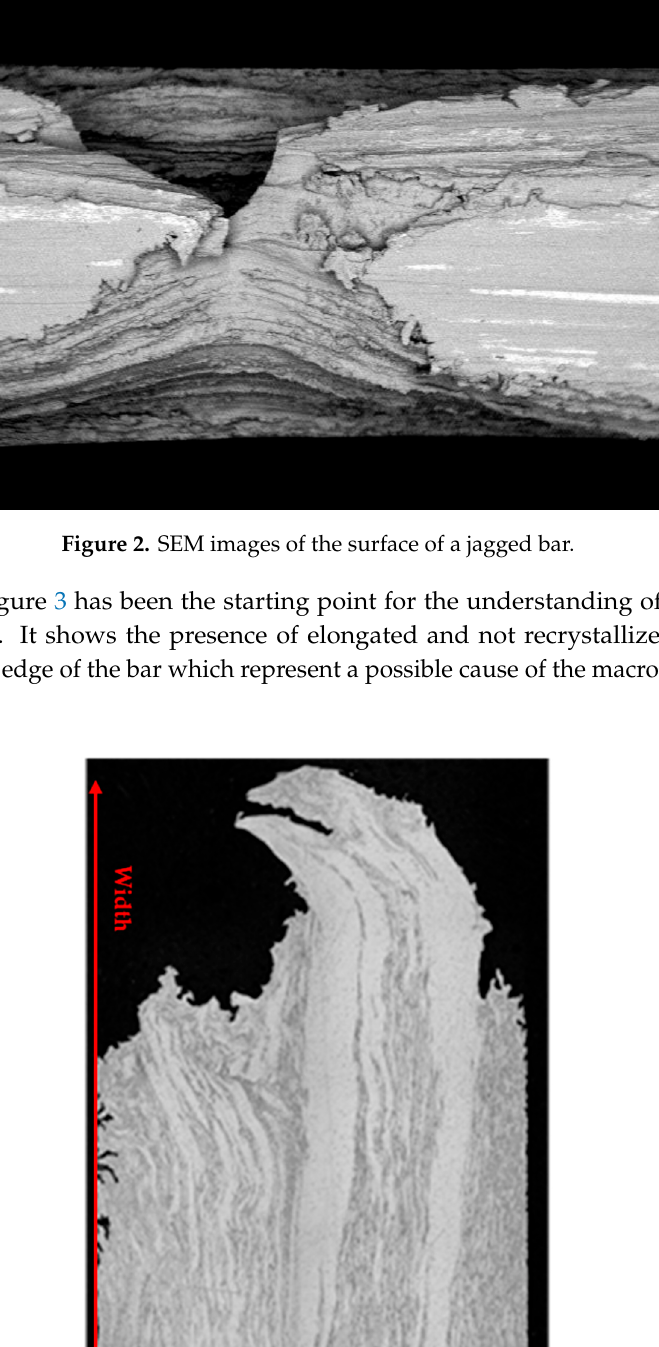
Figure 3. Optical micrograph showing a detail of the bar edge with the macroscopic defect. The elongated and work hardened grains at mid thickness appear to be extruded from the microstructure during hot working (2% Nital Etching).